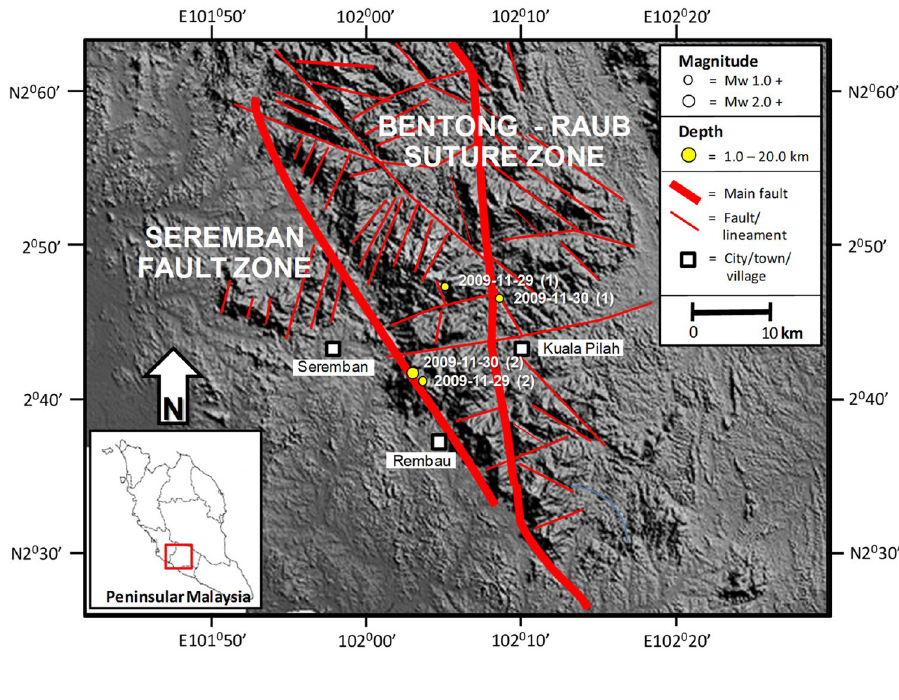
Fig. 8 Plot of earthquake epicenters during the studied period on the SRTM–DEM image in Manjung area. Red thinner lines here are lineaments indicating possible faults. Note: Created with